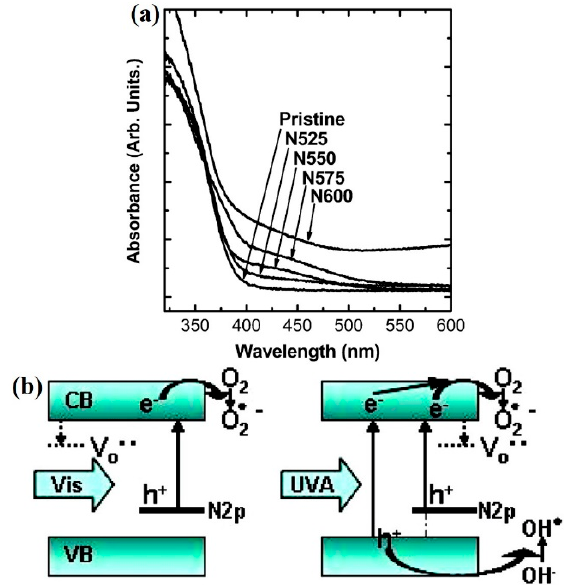
Figure 7. ( a ) Diffuse reflectance spectra of the anatase TiO 2 nanobelts before and after heat treatment in ammonia gas flow at different temperatures and ( b ) the band structure of N-doped-TiO 2 under visible and UV light irradiation [50]. Copyright © 2009 American Chemical Society.